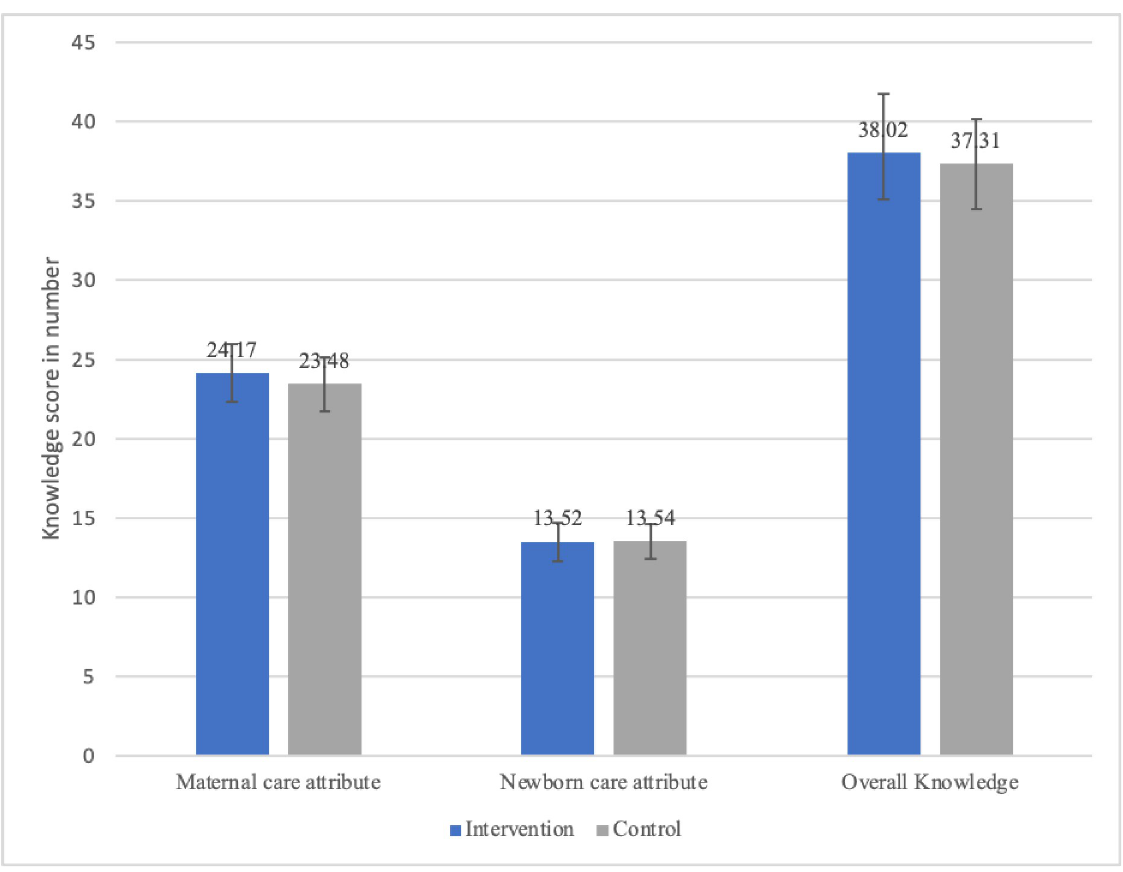
Fig 2. Bar graph showing PNC knowledge score of intervention and control group at